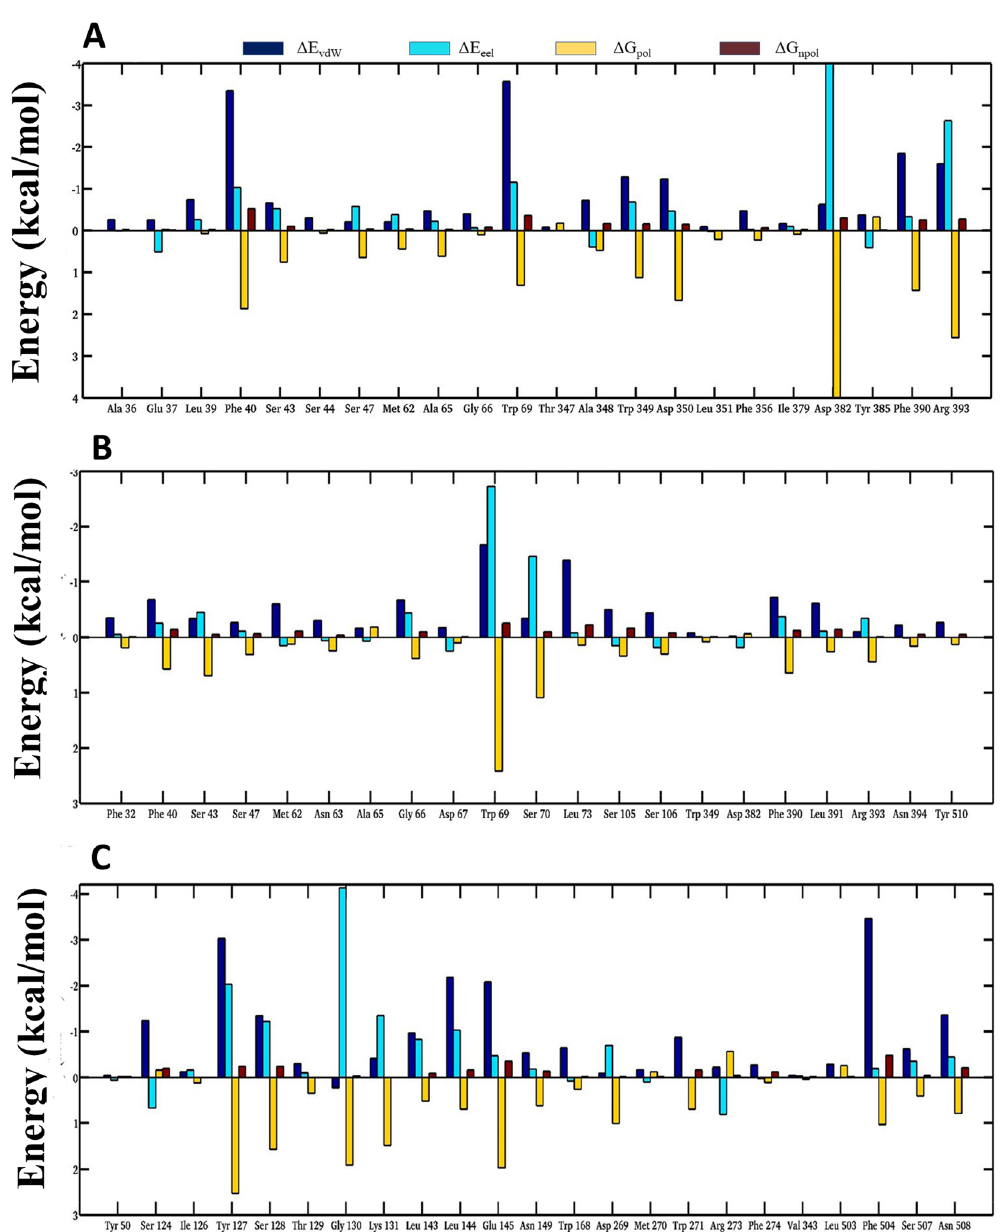
Figure 8. Binding energy contribution of the active site amino acids of ACE2 involve in interaction with the ligands ( A ) NF1 ( B ) NF12 and ( C )